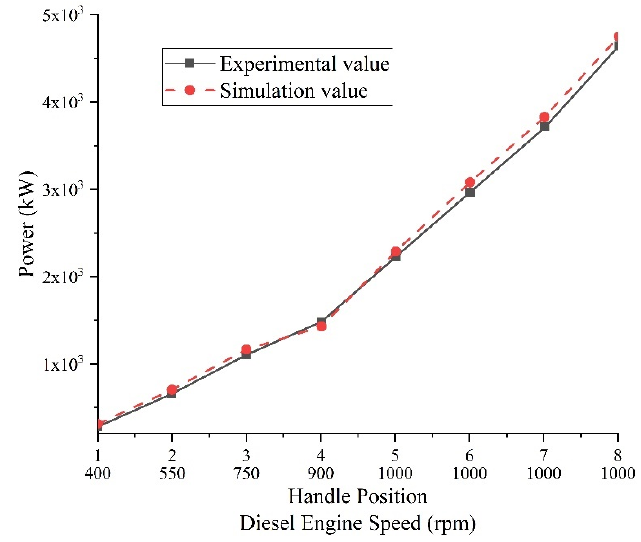
Figure 2. Comparison of power values.